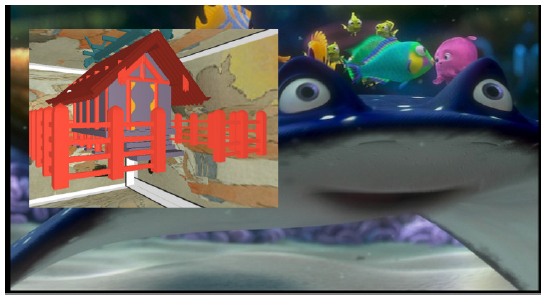
Figure 9. A NCL + X3D application running on the middleware Ginga.